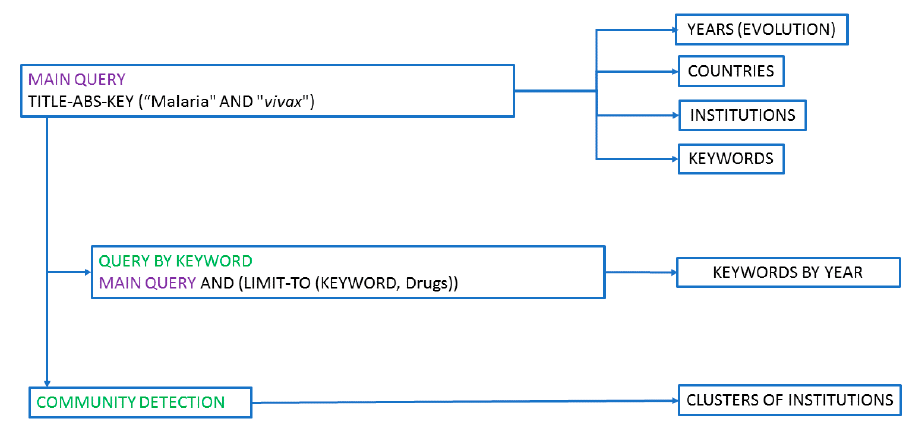
Figure 1. Methodology for searching the different analyses.